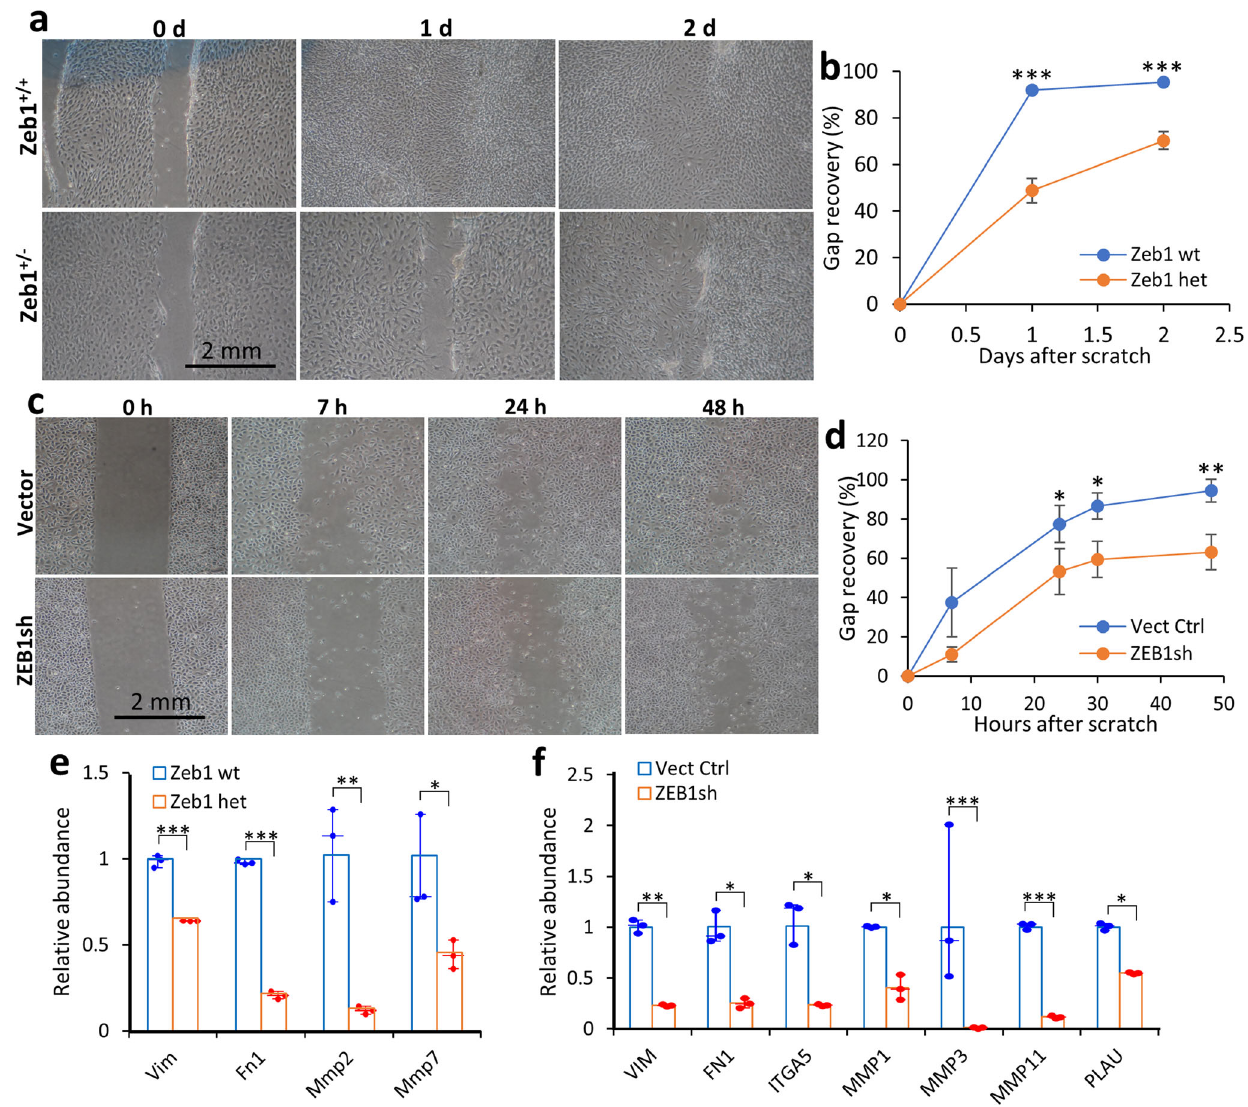
Fig. 6 Zeb1 promotes corneal epithelial cell migration. a The representative images of the epithelial cell monolayer cultures of both Zeb1 + / + and Zeb1 + / − corneas and b their migration rates. c The representative images of the hTECpi cell monolayer cultures of both the vector control (Vect Ctrl) and Zeb1-KD (ZEB1sh) and d their migration rates. e The monoallelic Zeb1-KO (Zeb1 het) in the mouse primary corneal epithelial cells and f ZEB1-KD (ZEB1sh) in the hTCEpi cells reduced the expression of cell migration-related ECM, the cell-matrix anchor and the matrix degradation enzyme genes in both mouse and human corneal epithelial cells. wt, Zeb1 + / + ; het, Zeb1 + / − ; * p ≤ 0.05; ** p ≤ 0.01; *** p ≤ 0.001. The error bars in b and d are the standard deviation (SD) bars whereas the box height in e and f is the mean with individual measurement